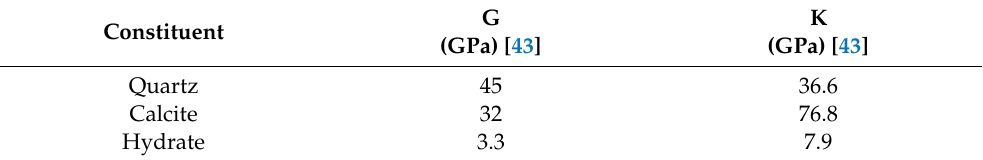
Table 4. Elastic properties of the solid